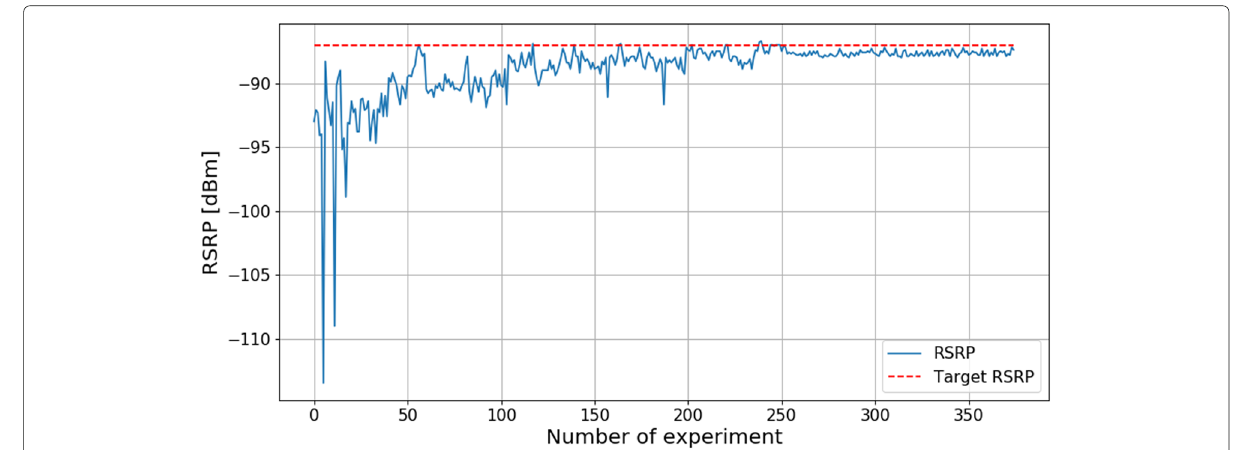
values of the configuration parameters for which the throughput and RSRP obtained in the simulations are closer to the target values. Finally, the values of configura- tion parameters, for which the target values of throughput and RSRP are achieved are in the serving cell transmission power case, – 7.6 dBm; in the interfering cell transmission power case – 14.9 dBm, and in the serving cell, the avail- able bandwidth is 100 physical resource blocks (PRBs) (20 MHz).